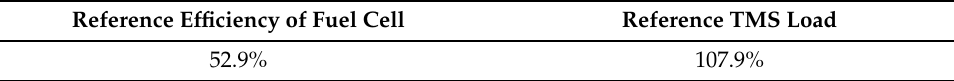
Table 5. Selection basis for thermal management system load [47].